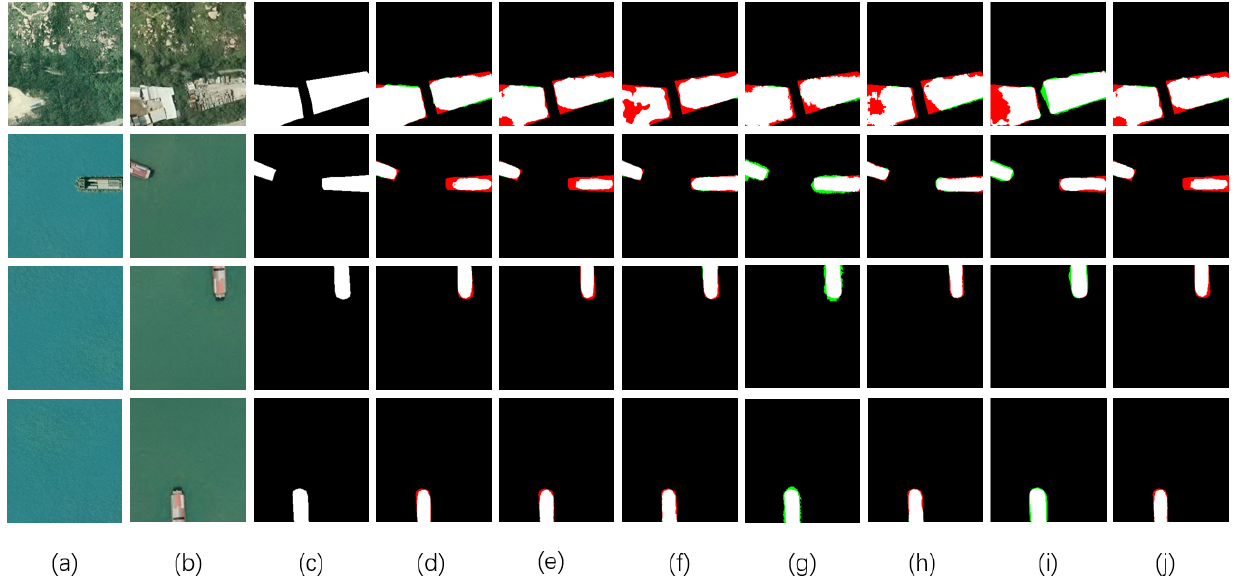
Figure 8. Visualization results of different methods for SYSU datasets. ( a ) T1 images. ( b ) T2 images. ( c ) Ground truth. ( d ) FC-Conc. ( e ) FC-Diff. ( f ) IFN. ( g ) DDCNN. ( h ) SNUNet. ( i ) BIT. ( j ) Ours. In the figure, white, black, red, and green represent TP, TN, FN, and FP, respectively.